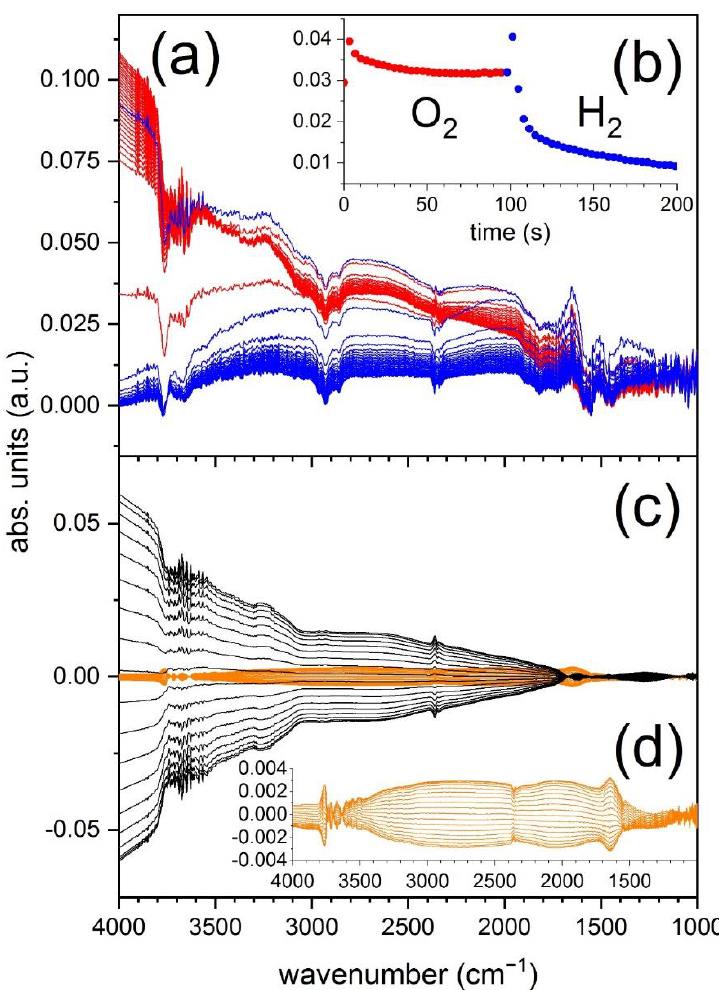
Figure 4. ( a ) Averaged time-resolved DRIFT spectra of 1.0 wt.% Pd/Al 2 O 3 during a O 2 /H 2 modulation period at 300 ◦ C. O 2 pulse, red spectra; H 2 pulse, blue spectra. ( b ) Temporal dependence of the signal at 2500 cm − 1 . ( c ) Corresponding phase-resolved DRIFT spectra (black) including those obtained from an identical experiment on Al 2 O 3 (orange). ( d ) Magnification of the phase-resolved spectra of Al 2 O 3 .